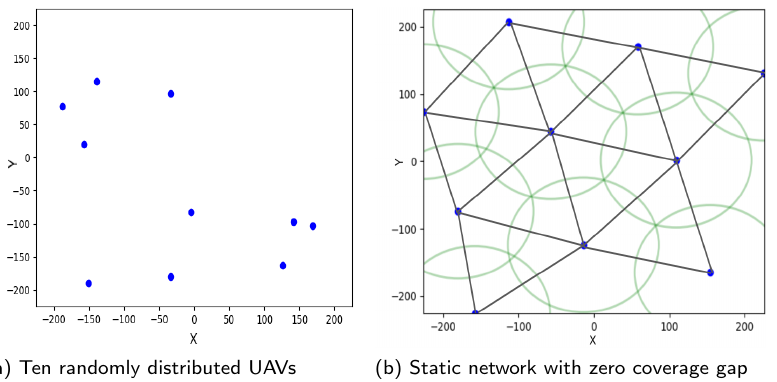
Figure 3. UAVs moving under the influence of potential fields with parameters ( c a , e a , c r , e r ) as √ (1, 1, 3 × 3 × 100 3 , − 2) to create a network with zero coverage gap.